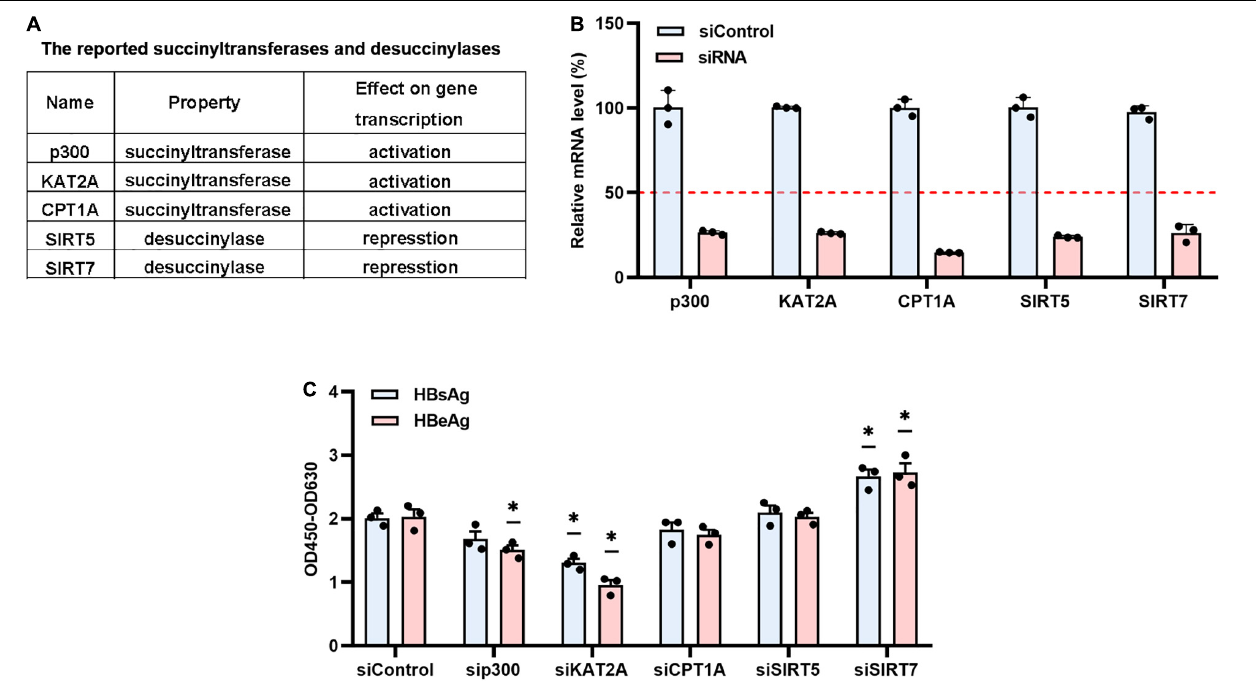
FIGURE 1 | Identification of KAT2A as a host factor promoting cccDNA transcription. (A) The reported succinyltransferases and desuccinylases were summarised in the table. (B) After 4 days of siRNA treatment, total RNA was extracted by TRNzol Universal reagent. The silencing efficiency of related genes in Huh-7 cells was analysed by real-time PCR with specific primers. β -actin was used as the internal control. (C) The indicated siRNA (50 pmol) and monomeric linearised HBV DNA (1 µ g) were co-transfected into huh-7 cells by using Lipofectamine TM 3000 Transfection Reagent. The supernatant was collected and HBeAg and HBsAg levels were detected by ELISA. * P <